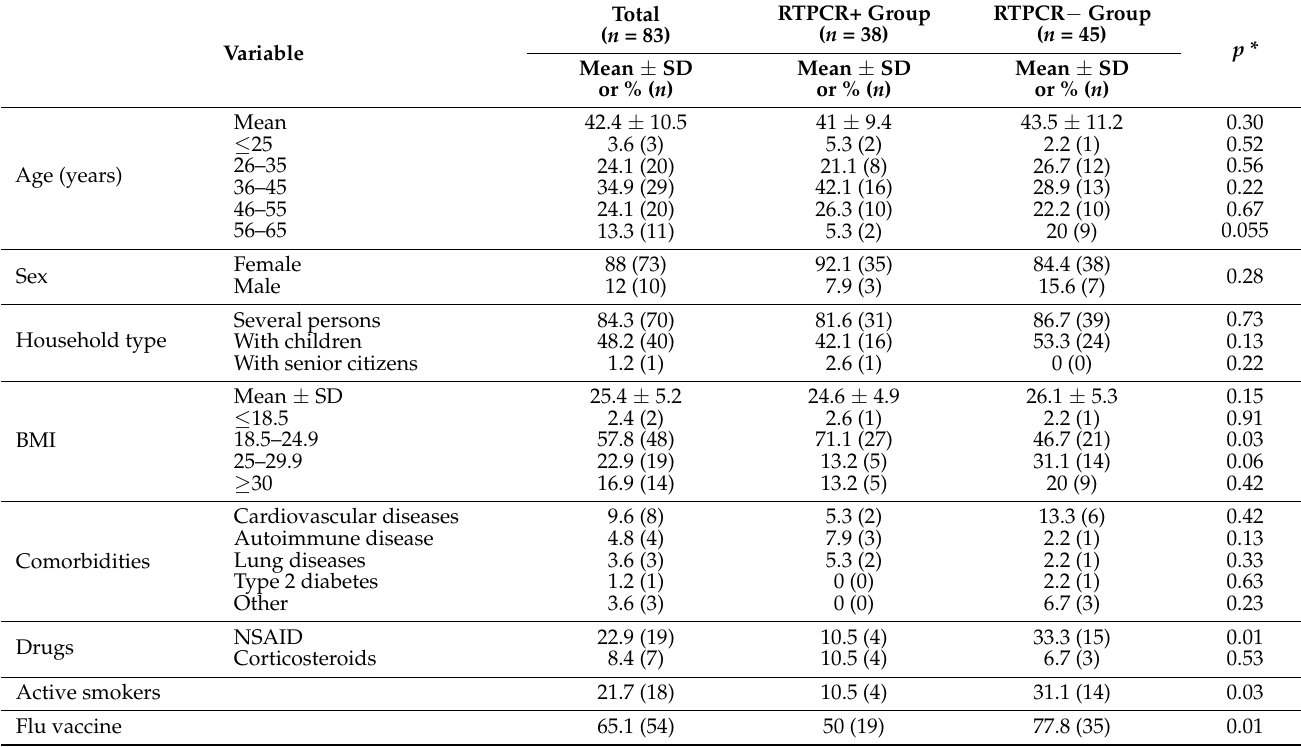
Table 2. Sociodemographic and medical characteristics of healthcare workers and comparison between the RTPCR+ and RTPCR − groups.